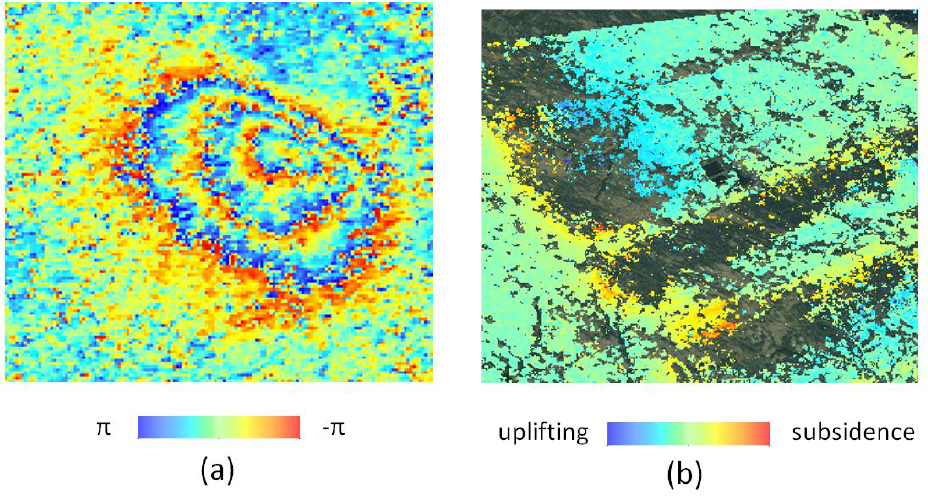
Figure 8. Typical patterns of underground mining subsidence in ( a ) DInSAR differential interferogram; ( b ) TS-InSAR velocity map [43].